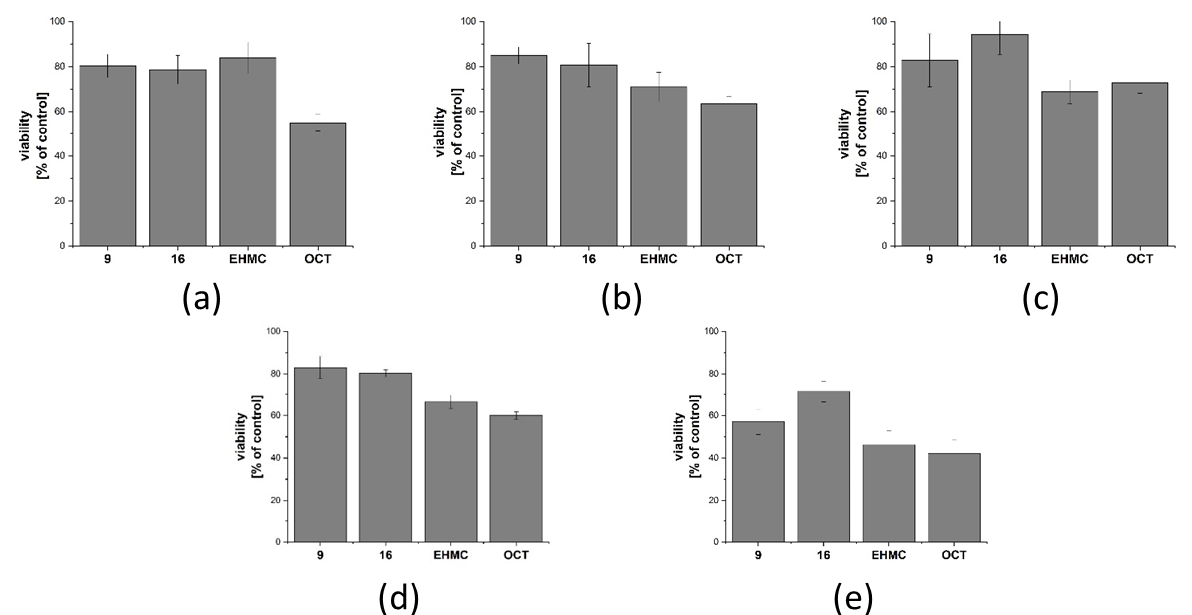
Figure 7. Viability of human keratinocytes HaCaT ( a ) and human skin fibroblast (BJ) ( b ) HepG2 cells ( c ), mouse astrocytes ( d ) rat cardiomyoblasts H9c2 ( e ) incubated for 24 h in the presence of compounds 9 and 16 , EHMC, and OCT at 50 µM. Cell viability was determined using MTT assay. Each experiment was repeated in triplicate. Graphs represent the number of viable cells expressed as percent of control (cells not treated with compounds) ± SD.